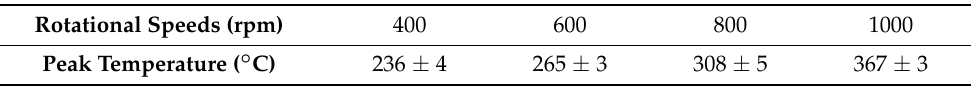
Figure 6. The generated heat input energy during the FSSW against the applied rotational speeds. The FSSW thermal cycles of the SZ in terms of the measured working temperature as a function of time at the different rotation speeds are shown in Figure 7. It can be seen here that the thermal cycle gives the same trend at the applied different rotation speeds from 400 to 1000 rpm at a constant dwell time of 3 s, with a difference in the measured peak temperatures at each rotation speed. The FSSW of the dissimilar thin thickness AA6082- T6 lap joints process can be divided into three stages. The first stage records the rising temperature gradually by penetrating the tool pin at a constant feed rate of 0.1 mm/s through the two sheets of the lap joint with direct contact of the tool shoulder with the top surface of the upper sheet at the applied rotation speed. The second stage represents the dwell time needed to achieve the spot joint at nearly temperature stability. The third stage (drawing out stage) represents the end of the welding process and air-cooling of the lap joint with gradually temperature loss. Table 3 lists the peak measured temperature in the SZ during the FSSW process. The temperature increases from 236 ± 4 to 367 ± 3 ◦ C with the increasing rotational speed from 400 to 1000 rpm, respectively. Table 3. The maximum measured temperature during the FSSW process at different rotational